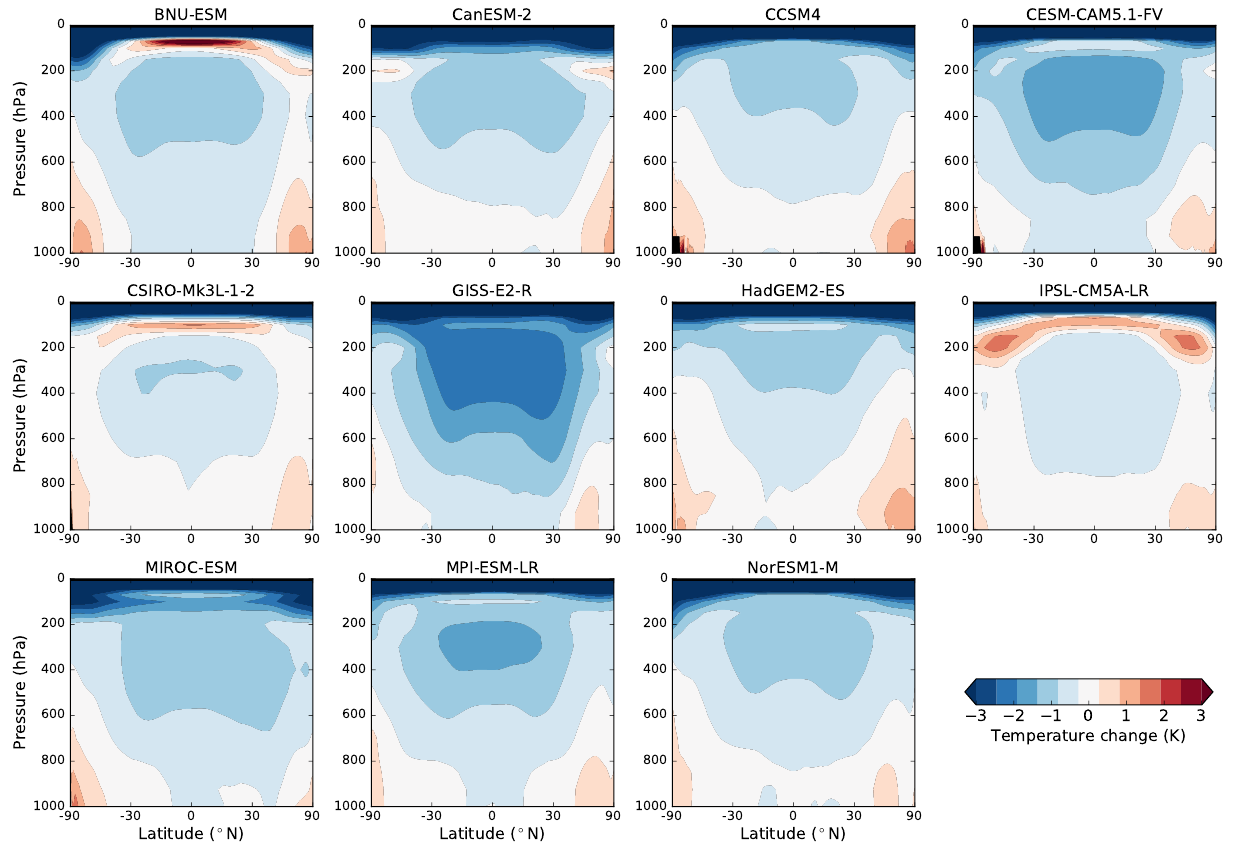
Figure 2. Zonal mean temperature change for G1 – piControl in each model as a function of pressure.